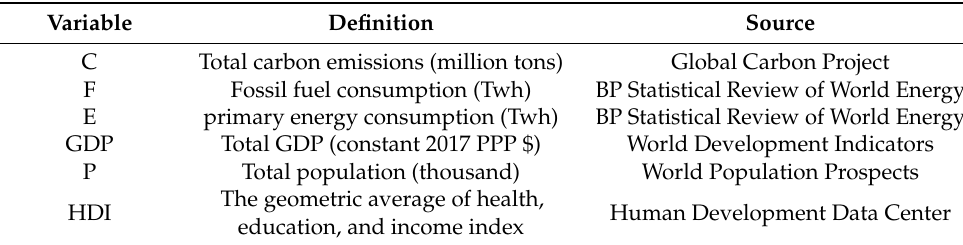
Table 1. Variable definition and